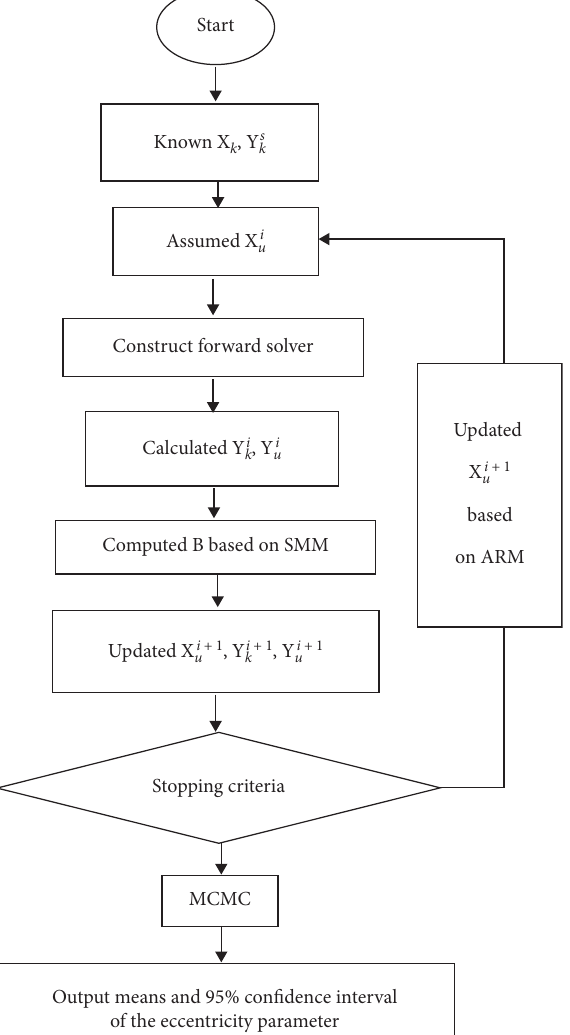
Figure 1: Identification flow